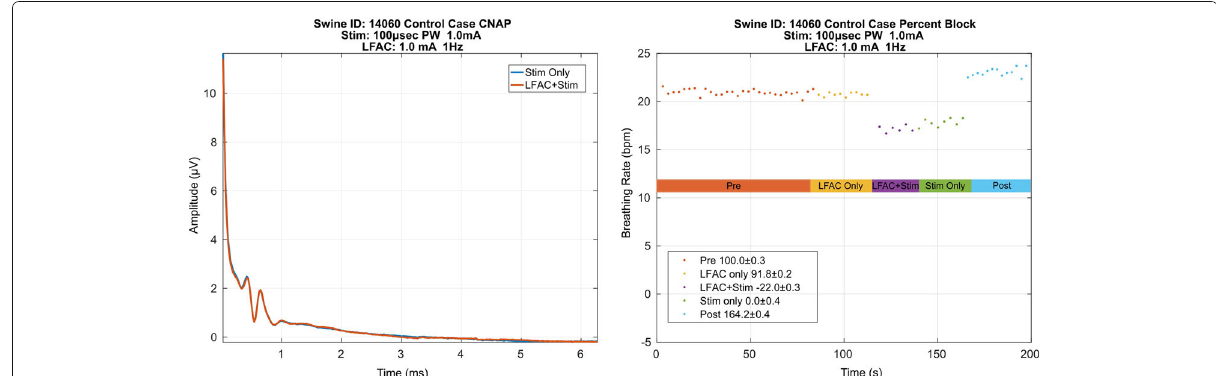
Fig. 9 ENG recordings during an LFAC control experiment. During the ’Stim Only’ epoch (left panel) there are 2 clear CNAPs. Conversely to what occurs in the test case, the LFAC waveform in the ’LFAC+Stim’ epoch does not affect the 2 CNAPs that are visible. The CNAPs visible in the ’LFAC+Stim’ epoch are unaffected and superimposed on those seen during the ’Stim Only’ epoch, which supports the hypothesis that LFAC block does not occur due to an electrode or waveform interaction. The right panel shows the breathing rate and percent block ( ± SD) during ’Stim